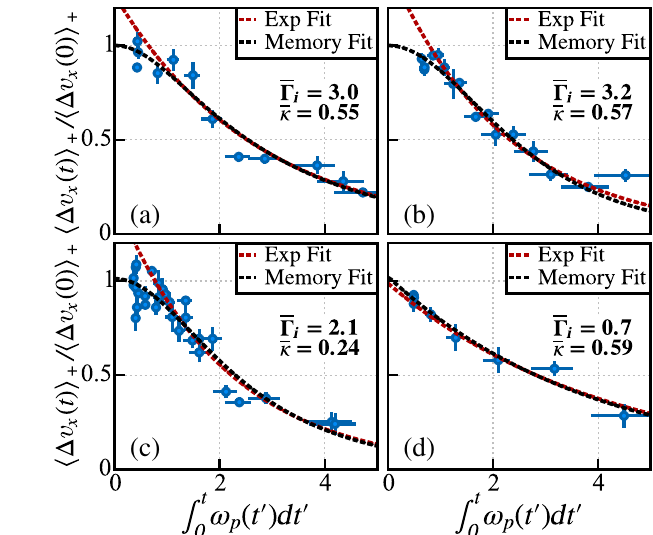
FIG. 3. Relaxation of the average velocity of spin þ 1 = 2 ions in an optically pumped plasma. Lines indicate memory-function and exponential fits to early-time data, as well as a t − 3 = 2 fit to the late-time tail. (a) h Δ v x ð t Þi two strongly coupled plasmas. (b) Data from (a) versus time scaled to the time integral of ω p . This plot shows the universal scaling of h Δ v x ð t Þi densities but with approximately the same (d) are the same plots as (a) and (b) but for a more weakly coupled plasma.